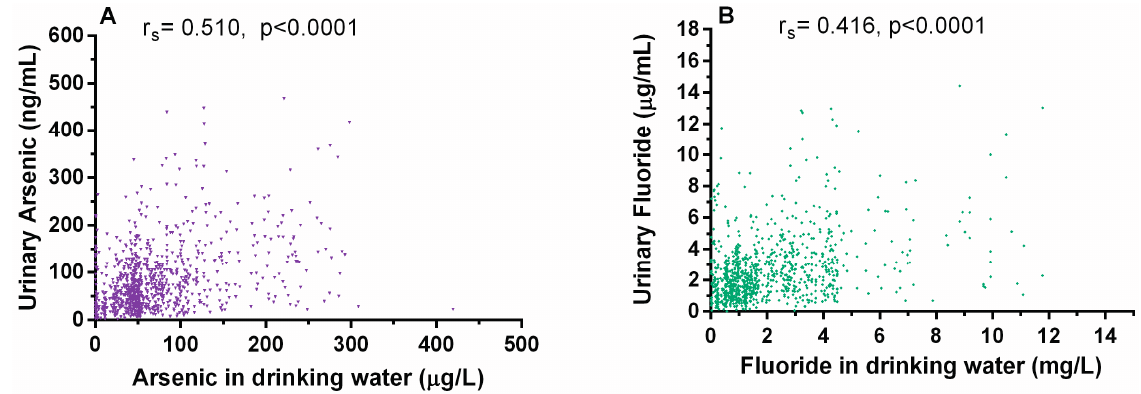
Figure 6. Correlations between arsenic and fluoride concentrations in water and urine: ( A ) Positive correlation between urinary arsenic and drinking water arsenic; ( B ) Positive correlation between urinary fluoride and drinking water fluoride. Urinary arsenic and fluoride concentrations were adjusted for specific gravity. Spearman correlation coefficient and p value are shown for 1119